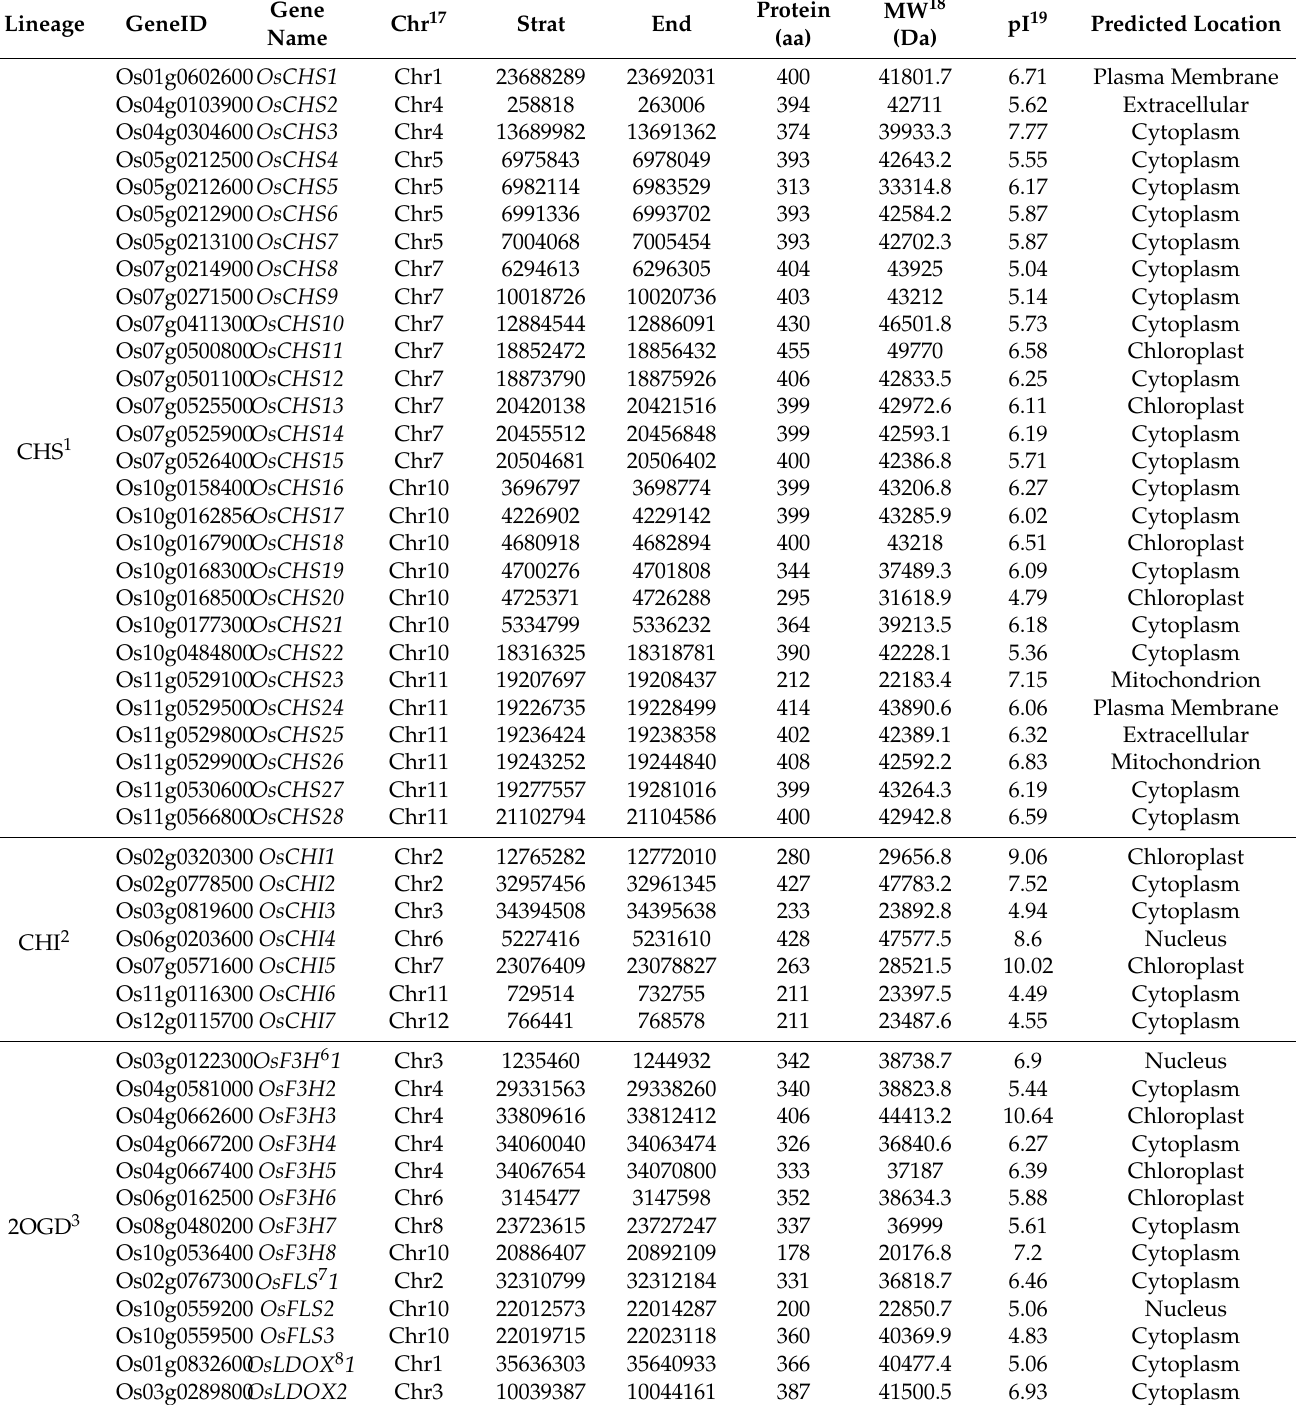
Table 1. Characteristics of the 85 putative flavonoid biosynthesis genes in